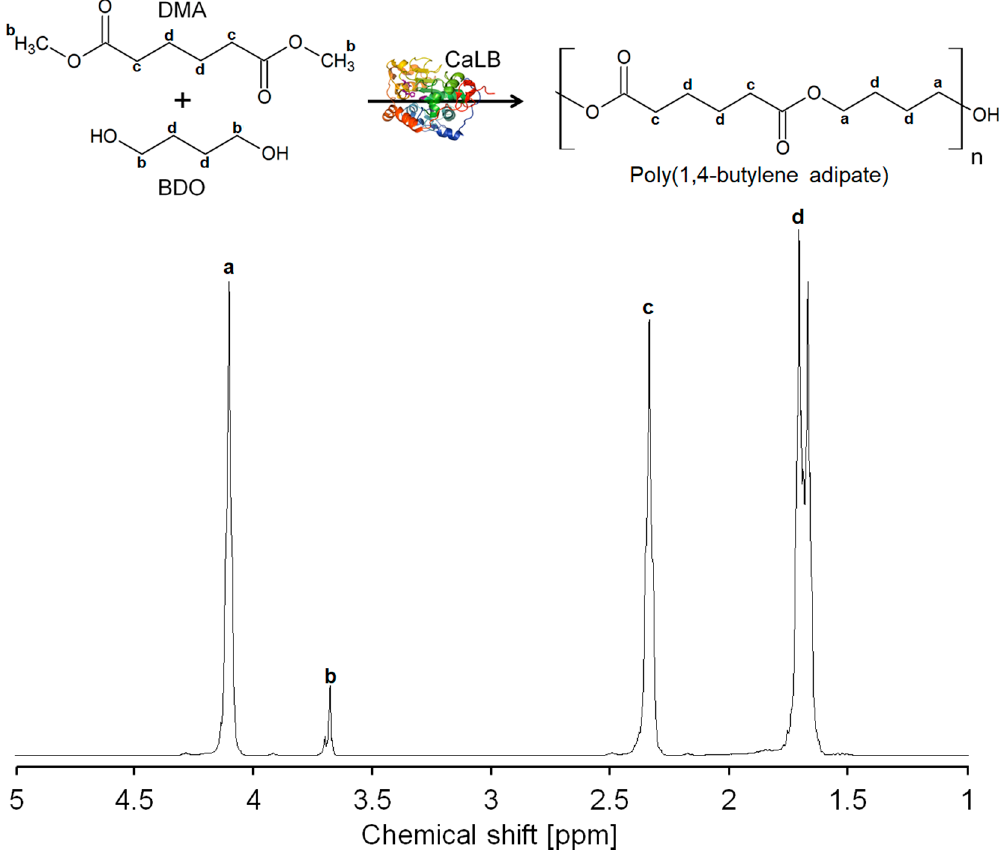
Figure 2. Enlarged 1 H-NMR spectrum of poly(1,4-butylene adipate) synthesized using immobilized CaLB starting from dimethyl adipate and 1,4-butanediol. Spectra was recorded using CDCl 3 as solvent.